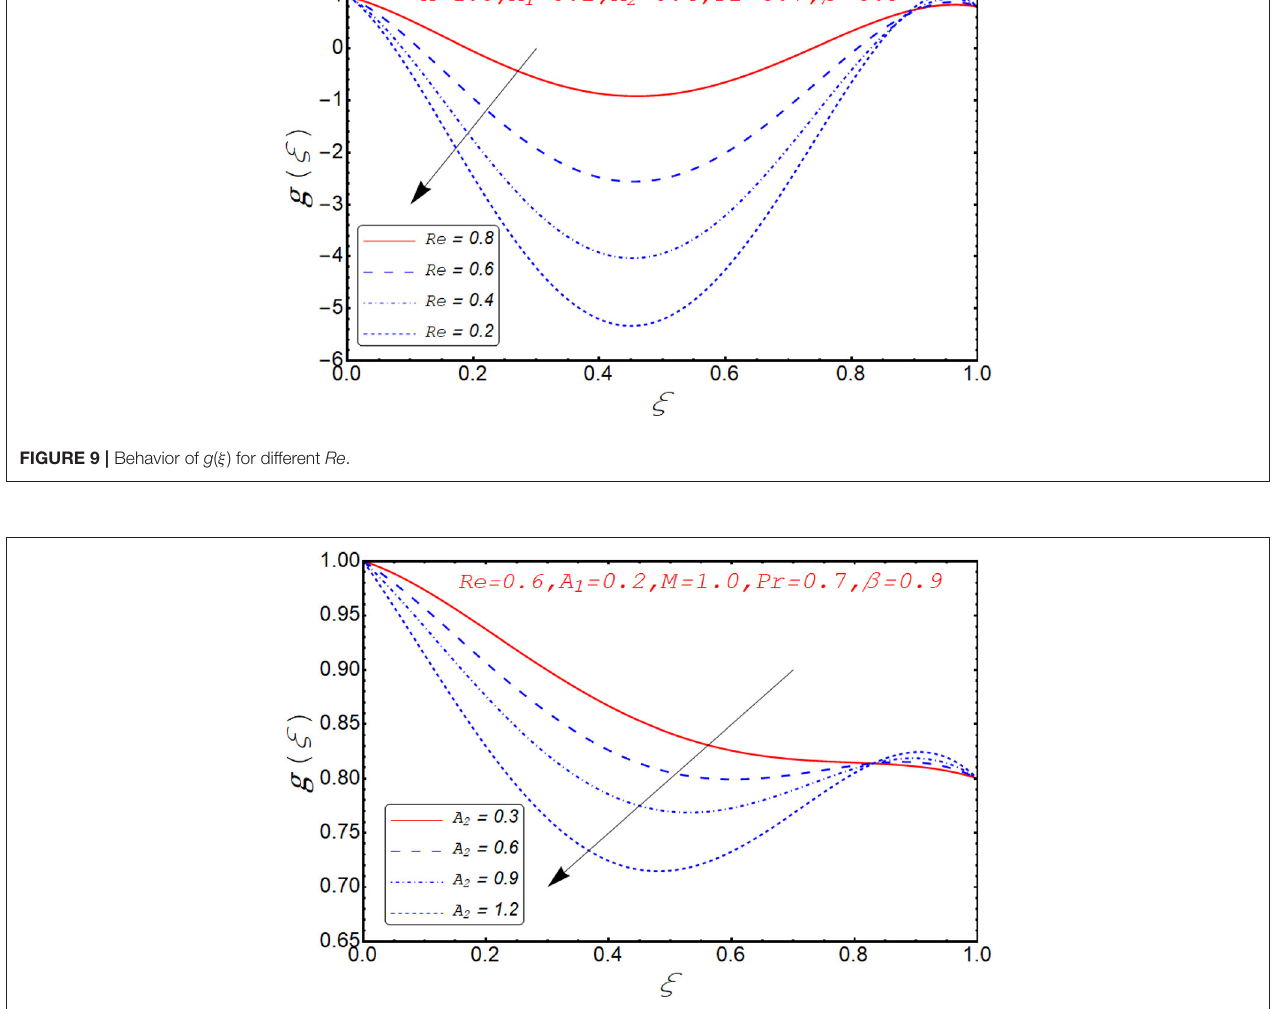
FIGURE 10 | Behavior of g ( ξ ) for different A 2